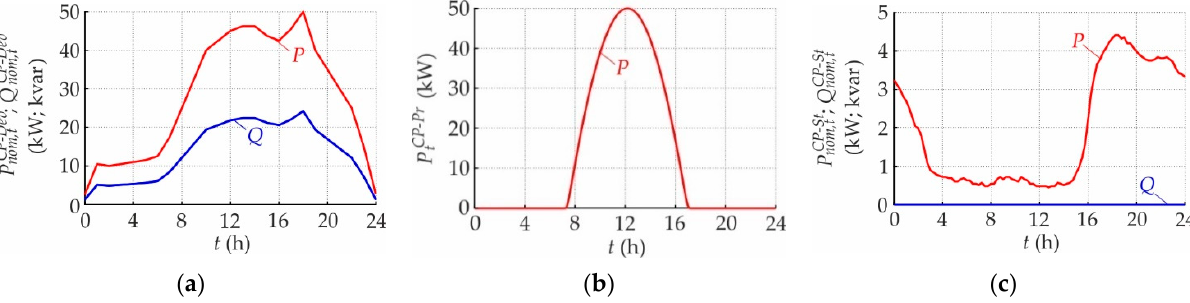
Figure A1. Load and production profiles of different model components of the commercial CP_Link-Grid: ( a ) Dev.-model; ( b ) Pr.-model; ( c ) St.-model.